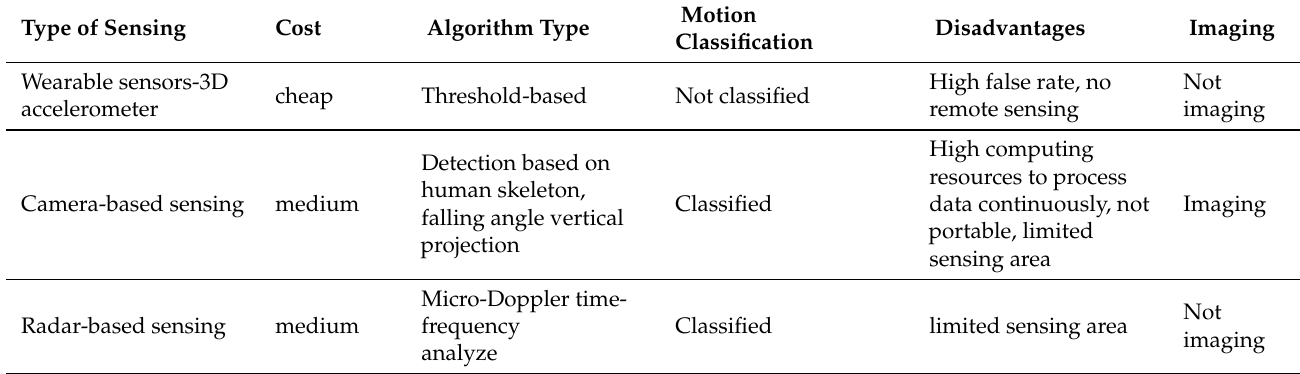
Table 1. Comparison of fall detection